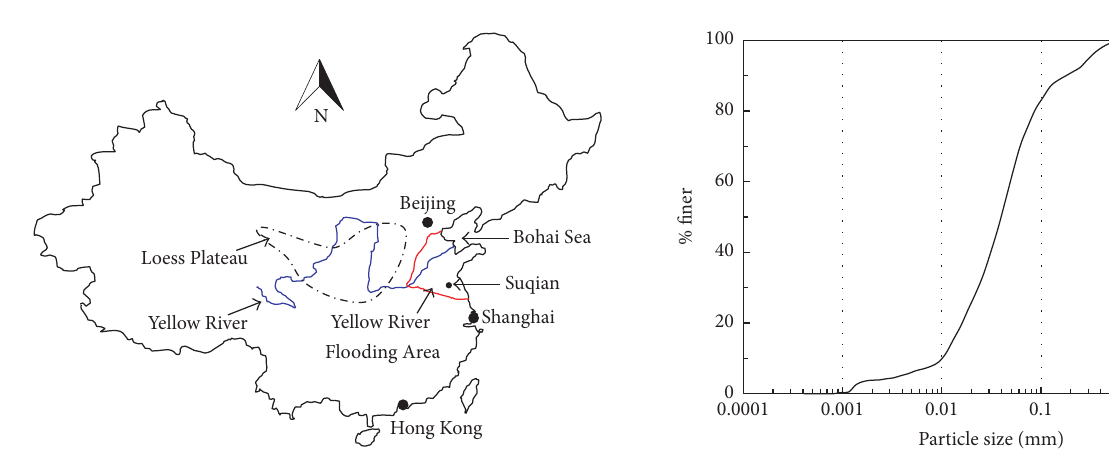
Figure 1: The Yellow River basin (not drawn to scale). Figure 2: Grain size distribution of soil